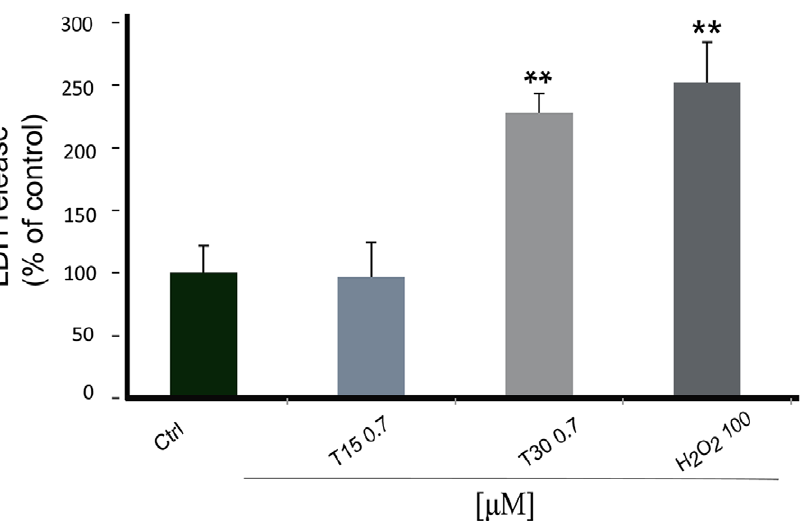
Figure 4. Bar graph showing lactate dehydrogenase release. Cells were treated for 1 hour with AChE C-terminus peptides of 30 amino acids (T30) 0.7 m M, the residual 15 amino acid sequence (T15) 0.7 m M and hydrogen peroxide (H 2 O 2 ) 100 m M. Data are presented as the percentage (of